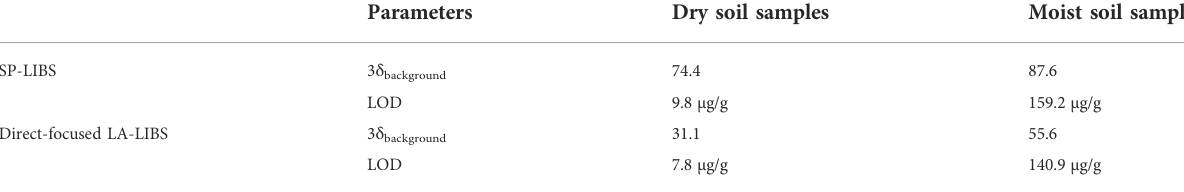
TABLE 5 Comparison of LOD for SP-LIBS and direct-focused LA-LIBS.